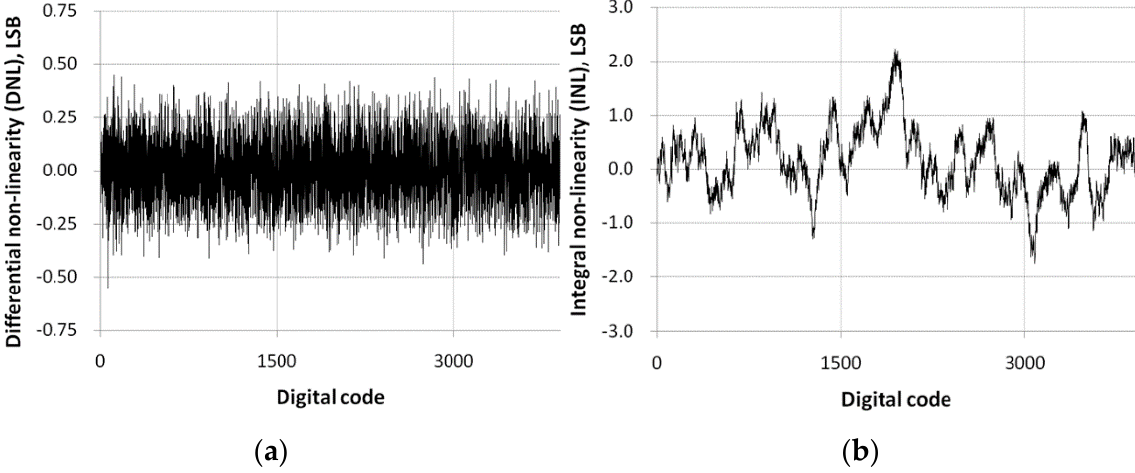
Figure 8. Measurement results of the linearity of the proposed pixel-level ADC: ( a ) differential non-linearity (DNL); ( b ) integral non-linearity (INL).